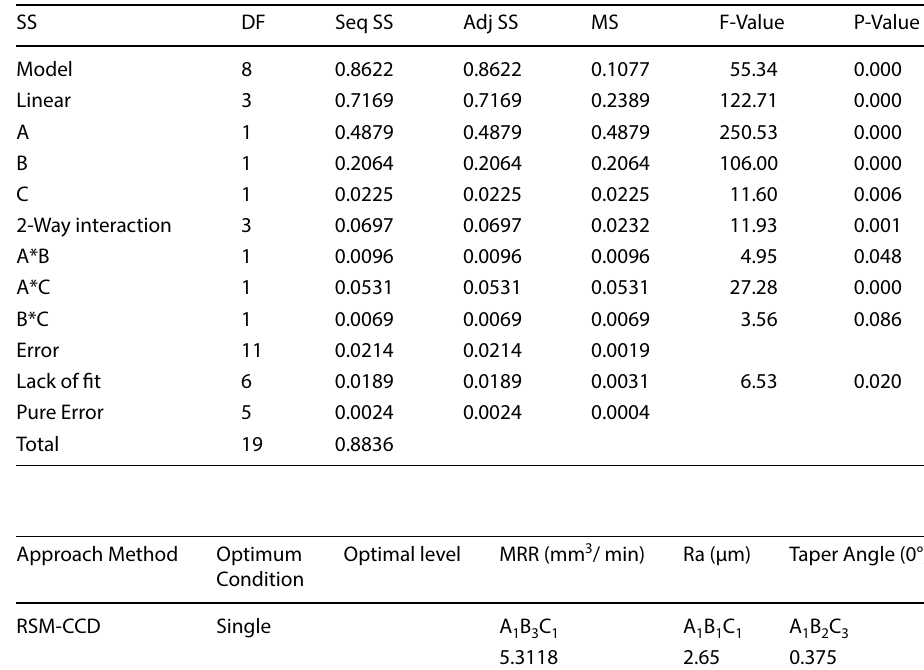
C/Gr composite 4